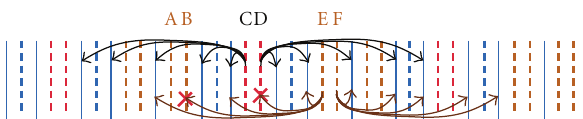
Figure 20: Coulomb transitions of nearest hole pair at ν = 6 / 17.